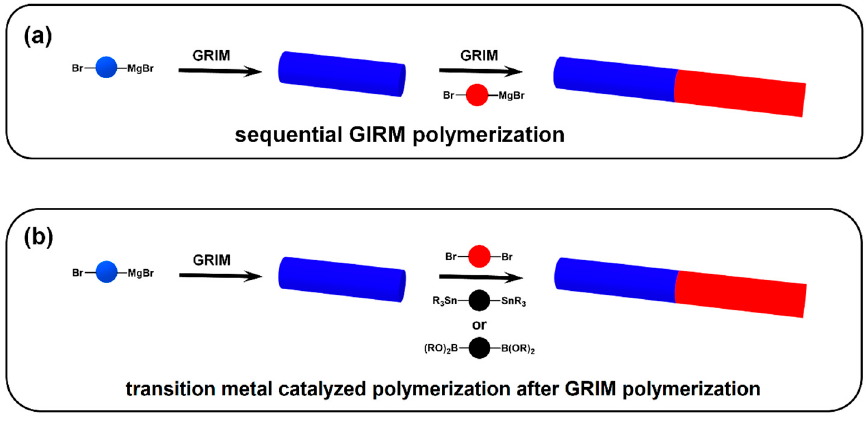
Figure 7. ( a ) The grafting-onto approach; ( b ) representative functionalized chain ends and reaction types.